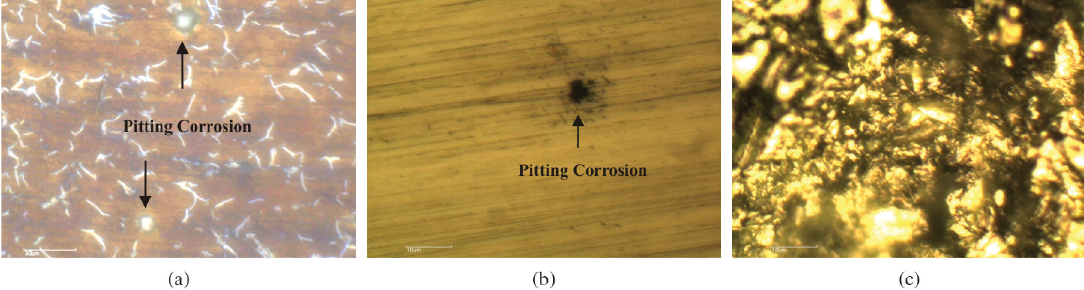
Figure 4. Optical micrograph of the samples surface: (a) Bare, (b) Sanded and (c) Shot peening, after potentiodynamic